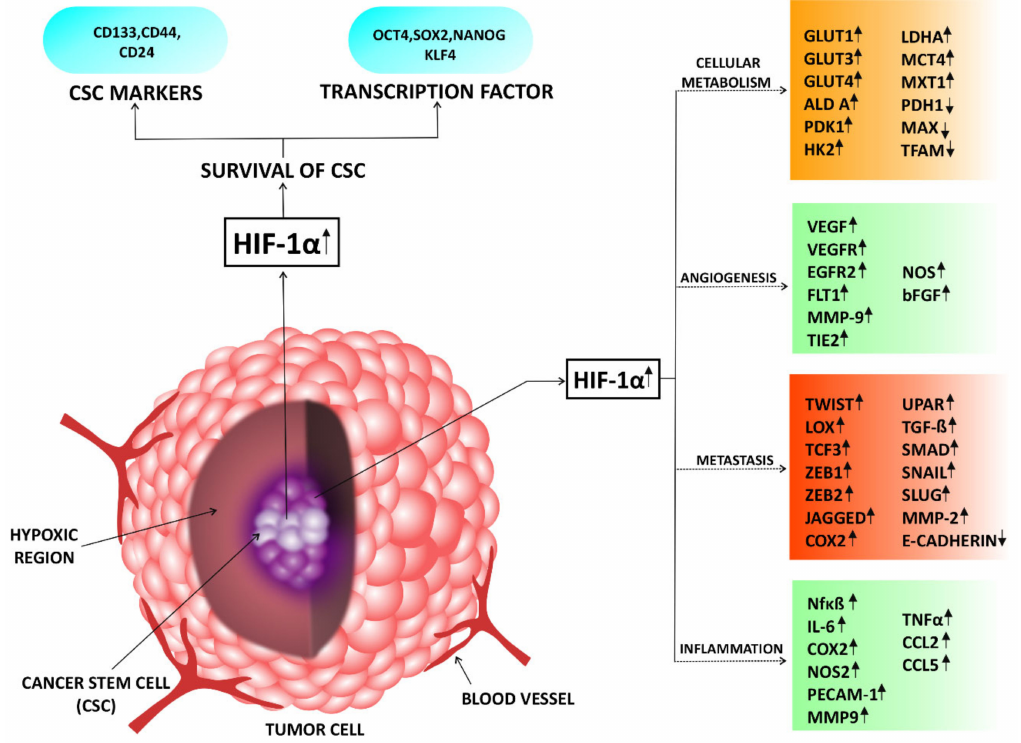
Figure 2. Representation of target genes of HIF-1 α involved in tumor progression: Figure represents tumor tissue with hypoxic region at its core. Cancer stem cell (CSC) population resides at the core region. In hypoxic tumor tissue, HIF-1 α helps in regulation of genes involved in cellular metabolism [41–66], angiogenesis [67–86], metastasis [87–102], CSC propagation & maintenance [103–111] and cancer in- flammation [112–122] which are listed in the figure. Upward arrows ( ↑ ) indicate increased expression of the protein and Downward arrows ( ↓ ) indicate decreased expression of the